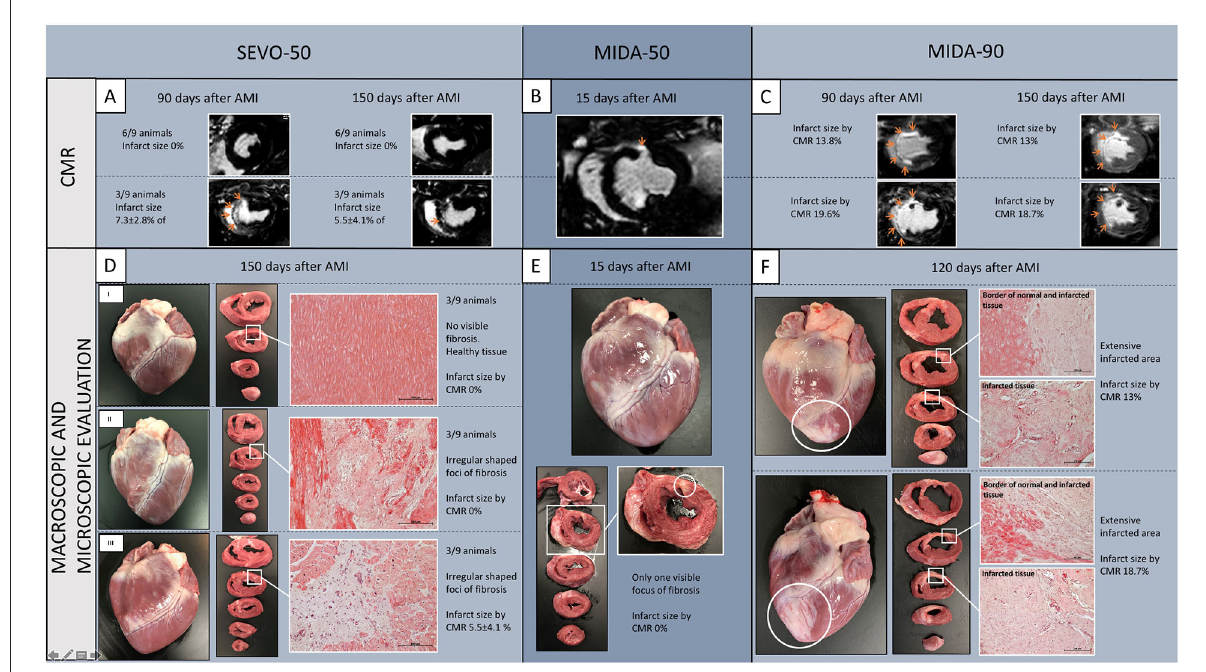
FIGURE1 Late gadolinium-enhanced CMR representative images from Study A, sub-group SEVO-50 (A) , the single MIDA-50 animal (B) , and sub-group MIDA-90 (C) . CMR analysis showed infarcts were significantly smaller in sub-groups SEVO-50 and MIDA-50 compared to sub-group MIDA-90. Arrows depict late gadolinium-enhanced infarcted myocardium. (D) Macroscopic view of the anterior wall of the heart and transverse slices from apex to base showing an example of myocardial integrity devoid of any fibrotic areas (DI), an example of small areas of fibrosis (white box) with 0% of infarct size documented by CMR (DII), and an example of visible small areas of fibrosis with 5.1% (7.3 ± 2.8%, group SEVO-50, n = 3) of infarct size documented by CMR (DIII). (E) Small area of fibrosis visible in the fourth transverse heart slice in the single MIDA-50 animal. (F) Examples of extensive transmural infarction resulting in fibrosis. Representative histological sections were stained by haematoxylin and eosin (Original magnification 100x). SEVO, sevoflurane; MIDA, midazolam; AMI, acute myocardial infarction; CMR, cardiac magnetic